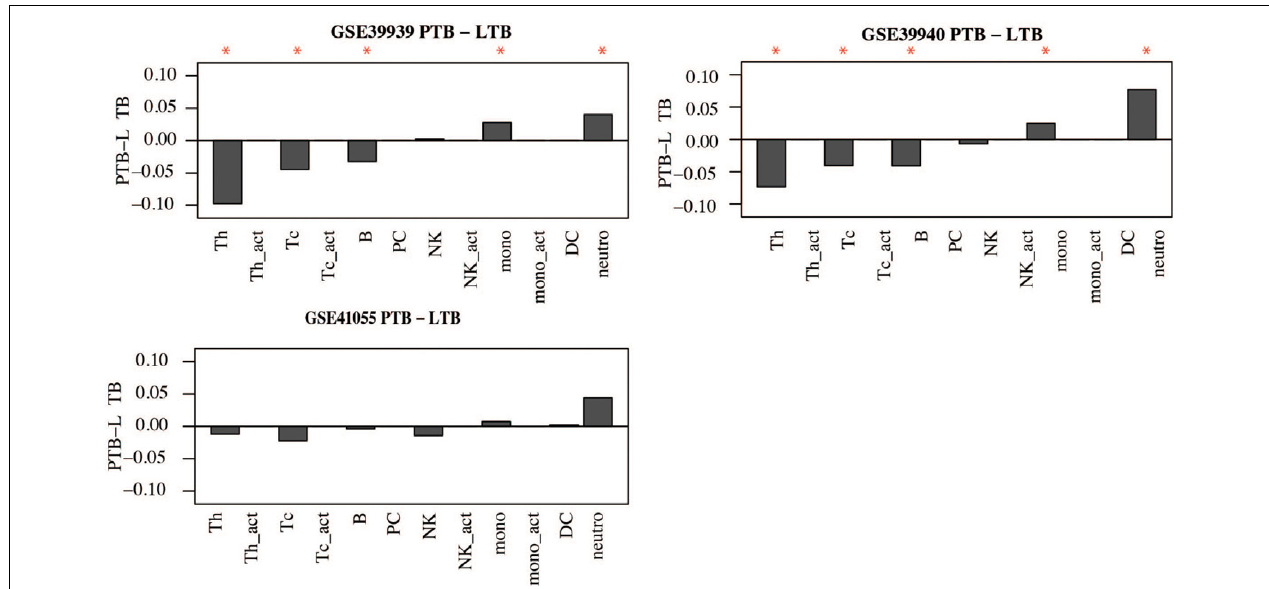
FIGURE 8 | Immune cell proportions in childhood TB. Immune cell proportions were deconvoluted from whole blood based on gene expression using CellMix. Median cell proportions of latent TB patients were subtracted from the median proportions from active TB for each cell in each study. Red asterisks indicate significant differences based on Student’s t